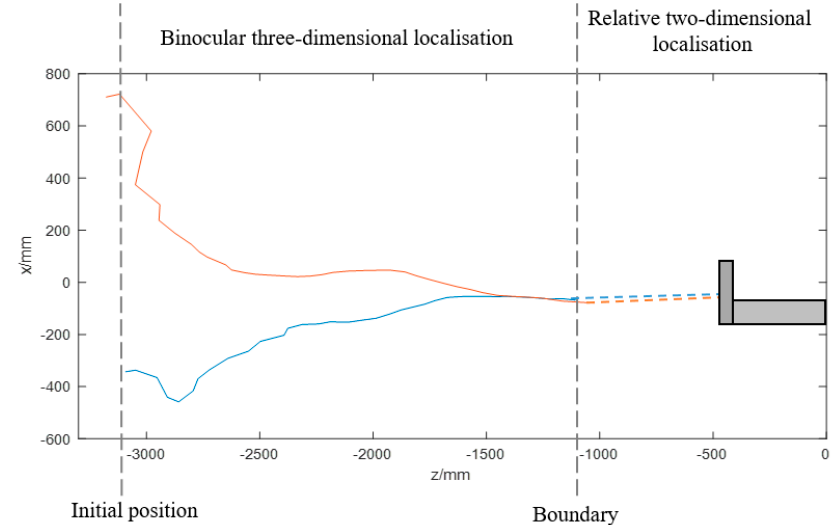
Figure 17. Horizontal trajectories of the ship model at different initial lateral deviations: the blue line illustrates the motion situation on the horizontal plane when the ship model starts at the right side of the docking station; the red line illustrates the situation when the ship model starts at the left side. The blue line in Figure 17 illustrates the motion displacement computed by the binocular vision algorithm on the horizontal plane when the ship model starts at the left side of the docking station. Its path is in reverse at the beginning, because it is in a slant direction. It takes time for the ship model to move towards the docking station by adjusting its yaw angles at a small P coefficient, as determined by the control strategy. The red line illustrates the condition in which the ship model starts at the right side of the docking